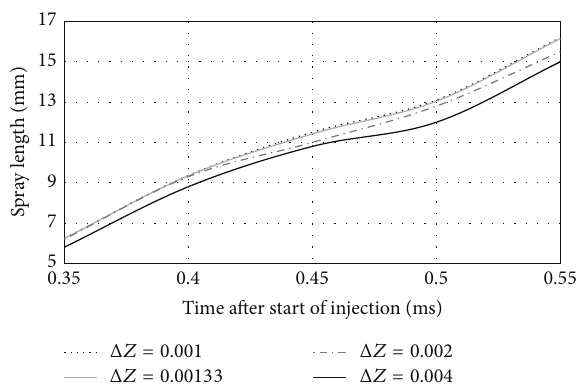
Figure 8: Resolution sensitivity analyses of butanol spray length at injection pressure of 720 bar.